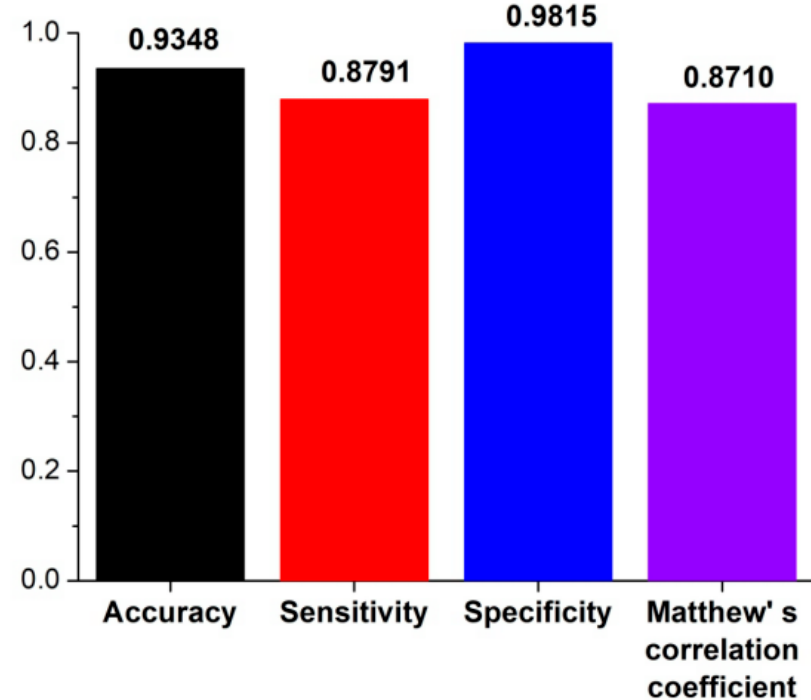
Figure 3. Sensitivity (Se), specificity (Sp), accuracy (Ac), and Matthew’s correlation coefficient (MCC) of riceMirP based on independent (unseen) testing dataset. Genes 2020 , 11 , x FOR PEER REVIEW